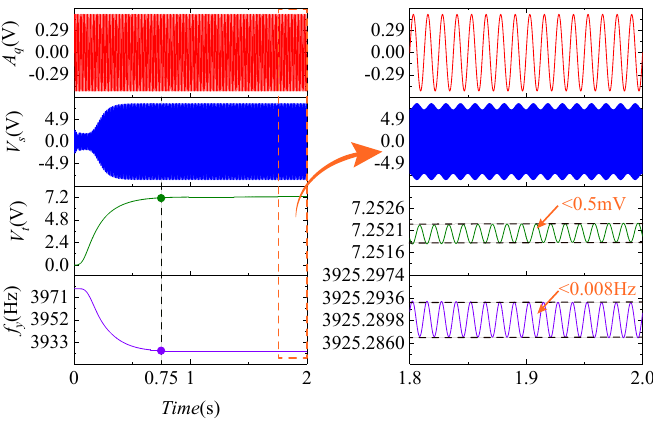
Figure 9. The curves of observation points in the frequency tuning system.